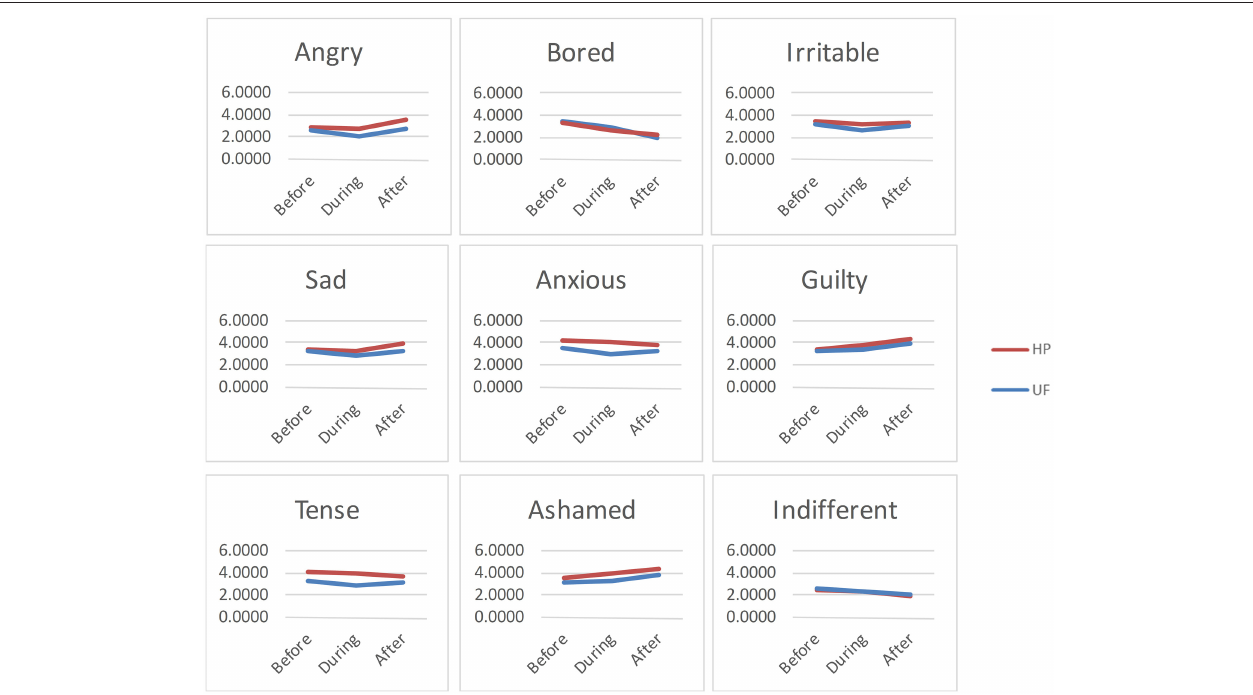
FIGURE 3 | Affective changes associated with urge satisfaction. UF + group: Plots of the changes in reported affect before, during, and after hair pulling (HP) or eating an unhealthy food